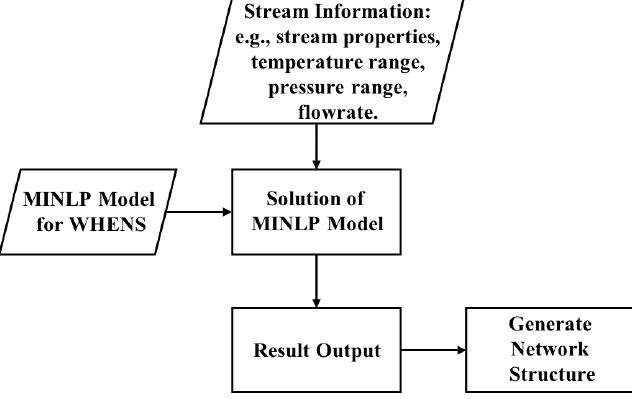
Figure 6. Procedure for block-based